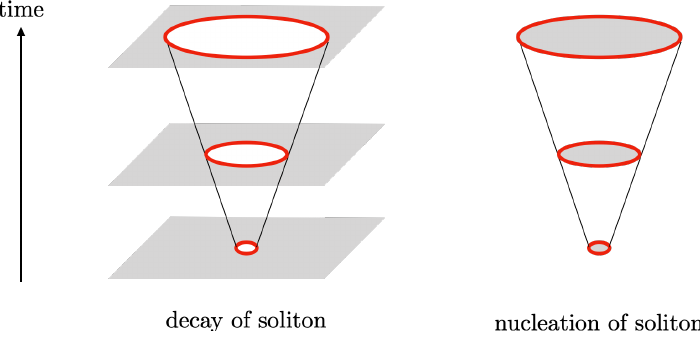
Figure 1 . The schematic picture of the decay of soliton by nucleating a hole (left) and the creation of soliton by nucleating a disk soliton (right). Grey objects stands for the solitons and the red objects corresponds to the